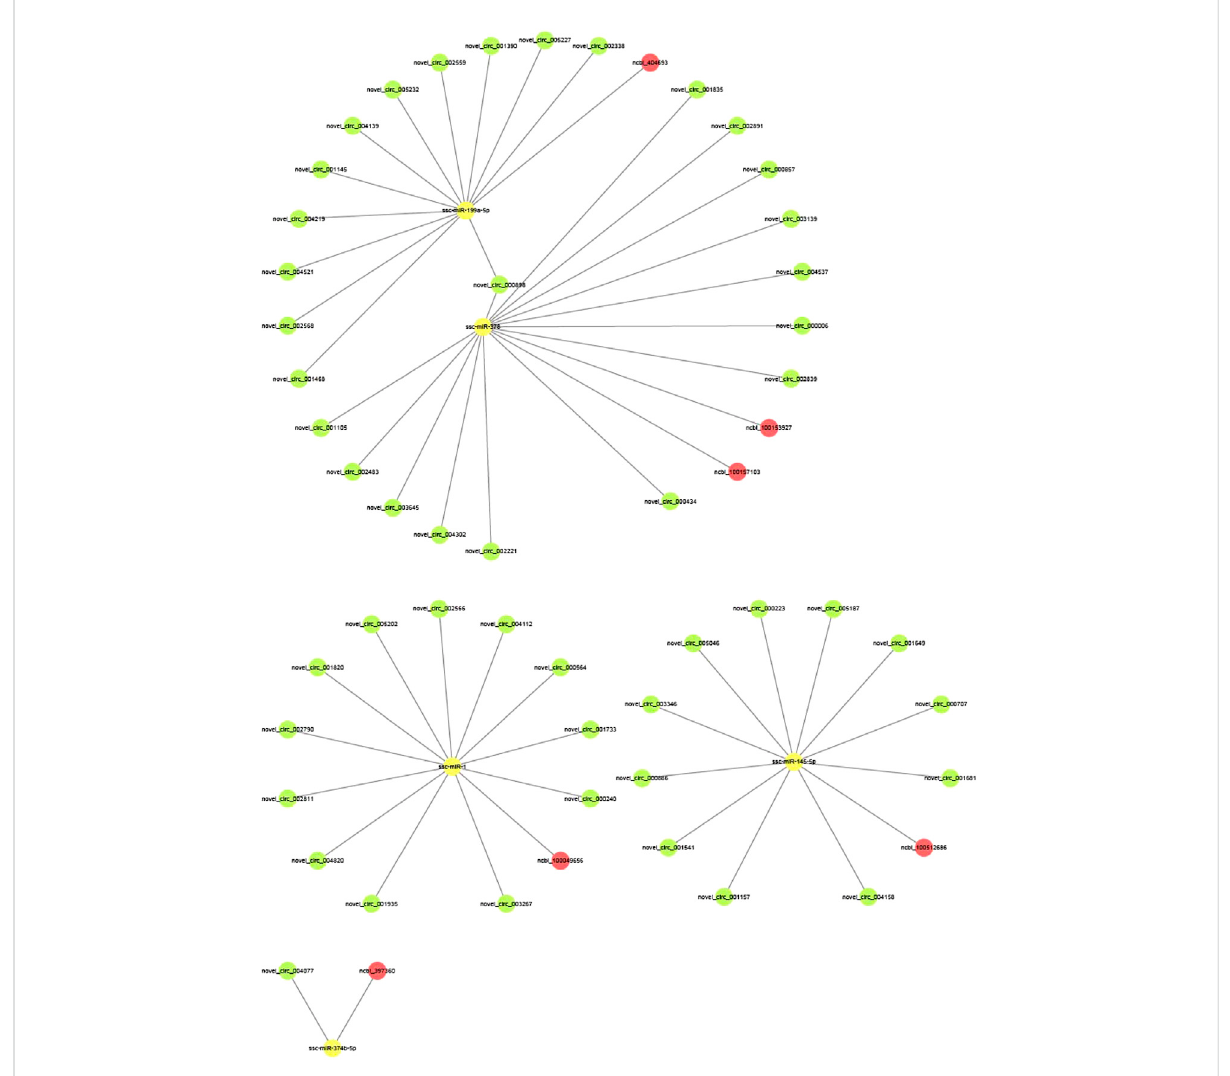
FIGURE 7 The circRNA-miRNA-mRNA interaction network. Green circles represent circRNAs, yellow circles represent miRNAs, and red circles represent